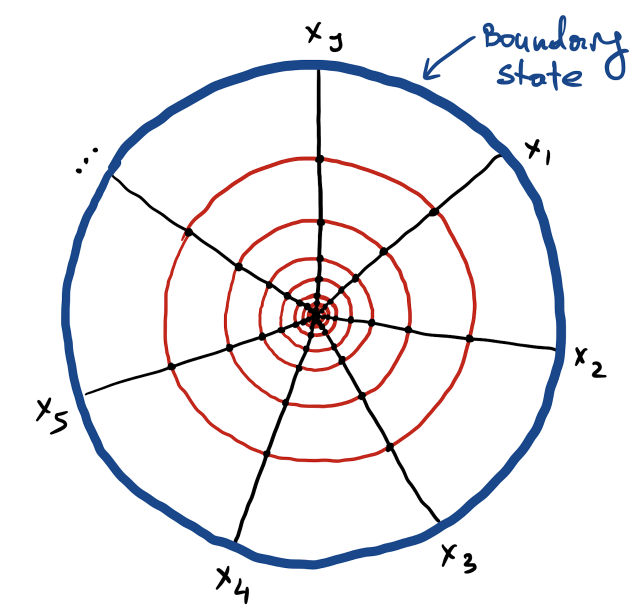
Figure 4 . An example of the overlap of CFT wave function with a boundary state in the fishnet model is a correlation function between a local operator and a circular Wilson-Maldacena